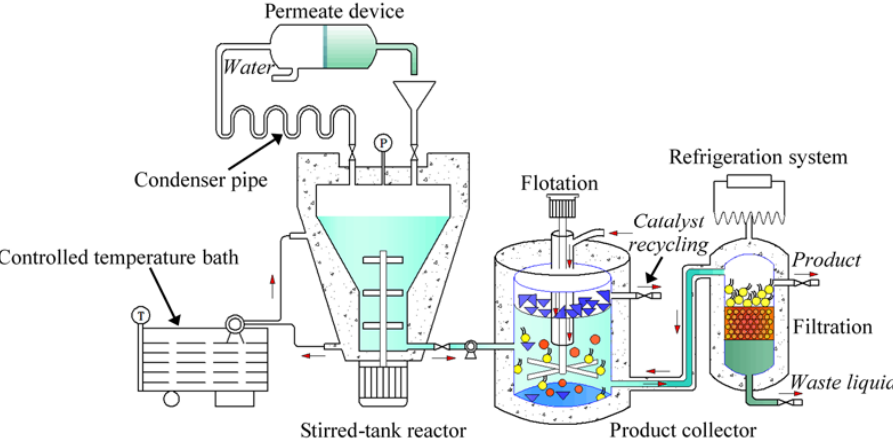
Figure 2. Schematic illustration of the enzymatic process.